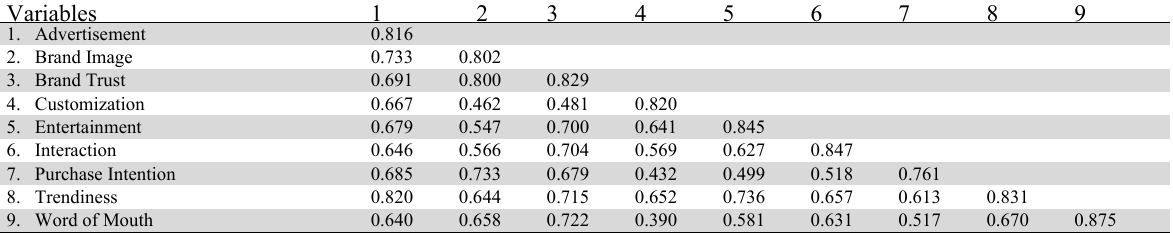
Discriminant Validity